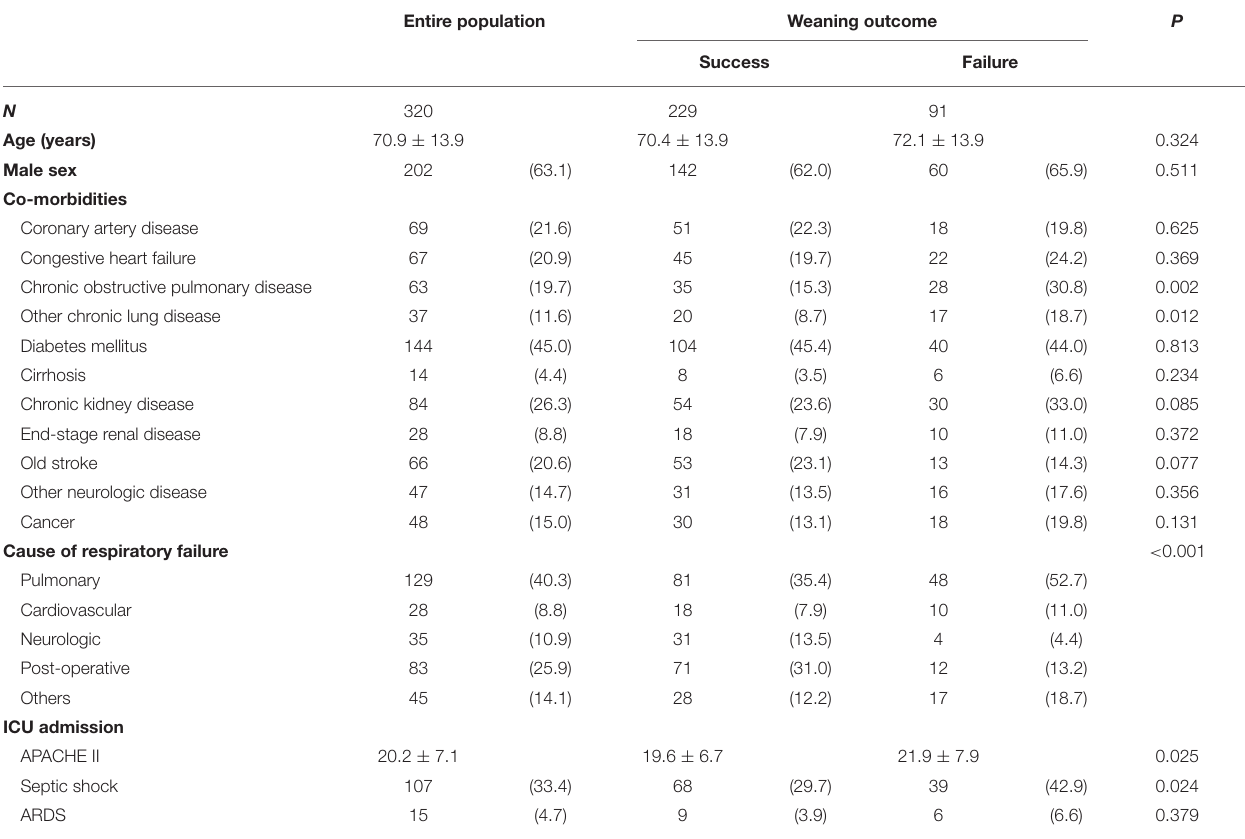
TABLE 1 | Clinical characteristics at baseline and intensive care unit admission. Entire population Weaning outcome